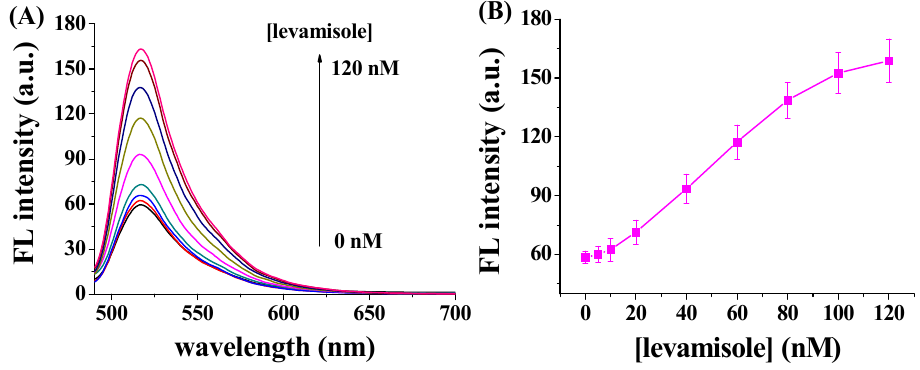
Figure 5. ( A ) Fluorescence spectra of 100 nM FITC–GGGYpR/GO in the presence of 10 nM ALP and different concentrations of levamisole (0, 5, 10, 20, 40, 60, 80, 100 and 120 nM); ( B ) Dependence of the fluorescence intensity on the concentration of levamisole.